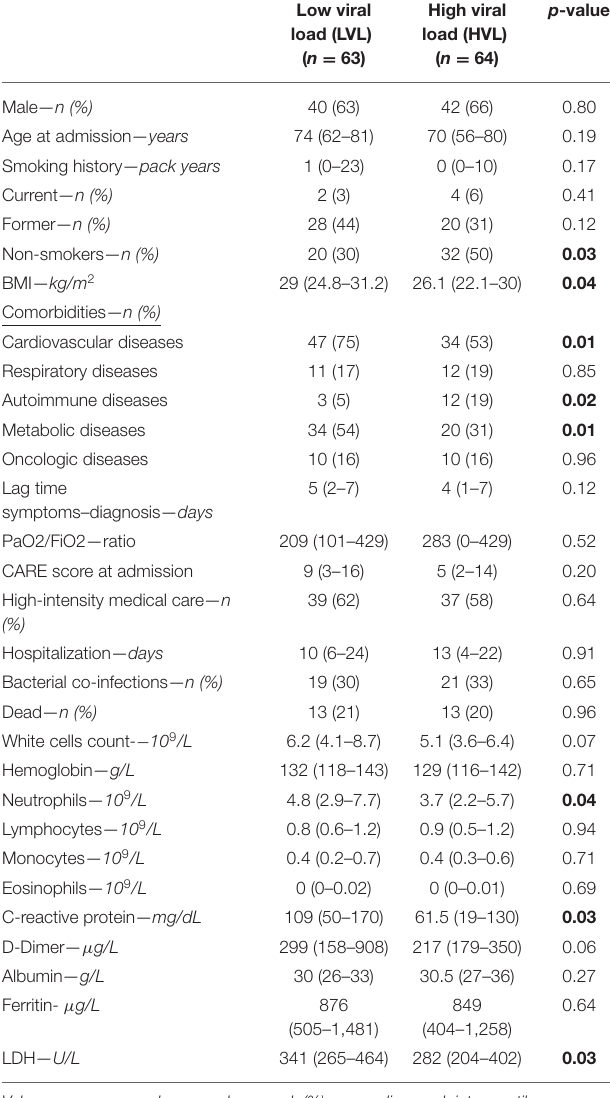
TABLE 3 | Baseline demographics and clinical features of the population hospitalized for SARS-CoV-2 related infection categorized in low (LVL) and high (HVL) viral